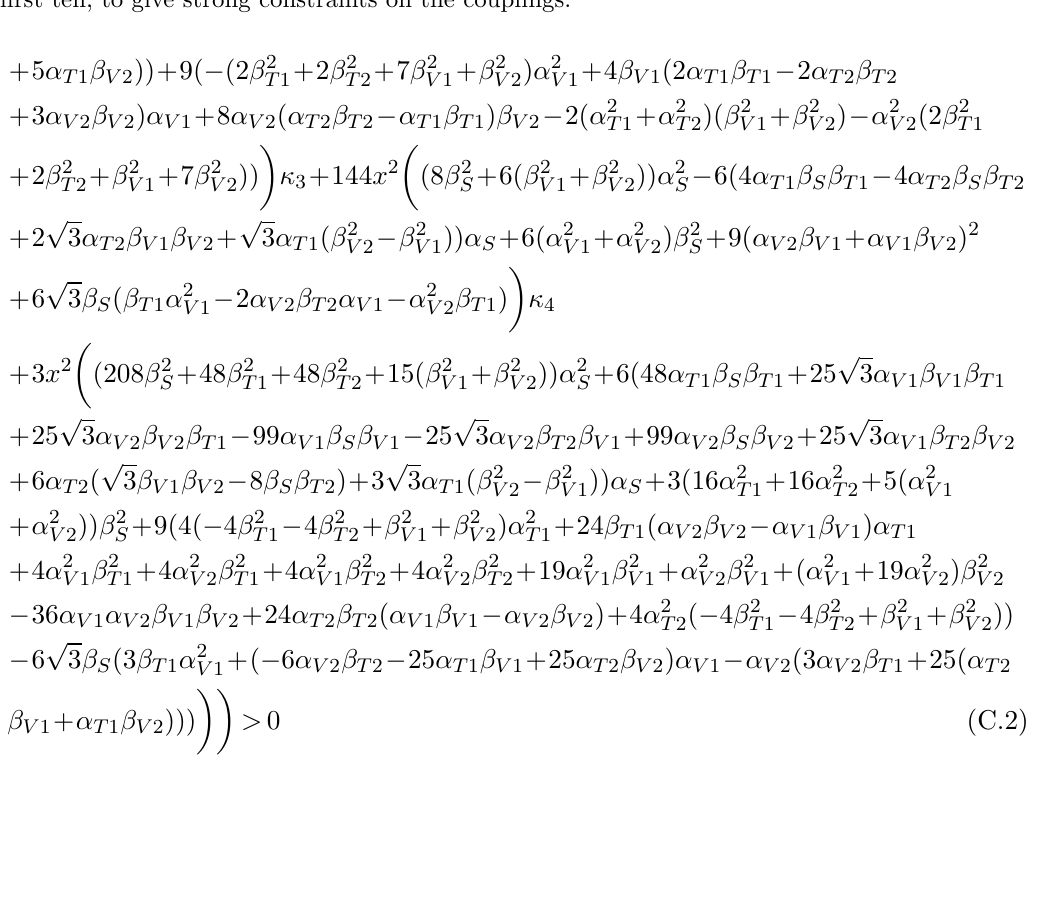
Table 4 . Special con(cid:12)gurations of polarizations for hh ! hh scatterings in SVT basis which give strong constraints on the couplings. These are determined by minimizing the (cid:11) ’s and (cid:12) ’s for guessed Lagrangian parameters. This procedure is repeated until a compact parameter region is obtained. In the case of line theories, the last six con(cid:12)gurations of polarizations are needed, in addition to the (cid:12)rst ten, to give strong constraints on the